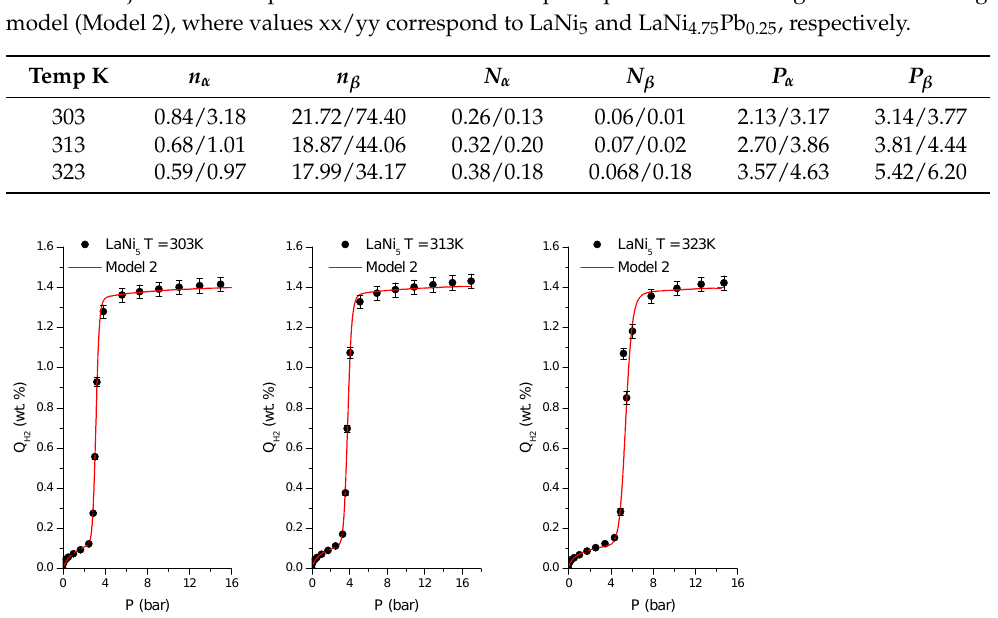
Figure 1. Hydrogen absorption isotherms for LaNi 5 at 303 K, 313 K, 323 K. The black circles are the experimental pcT data and the line is the simulation data obtained by using Model